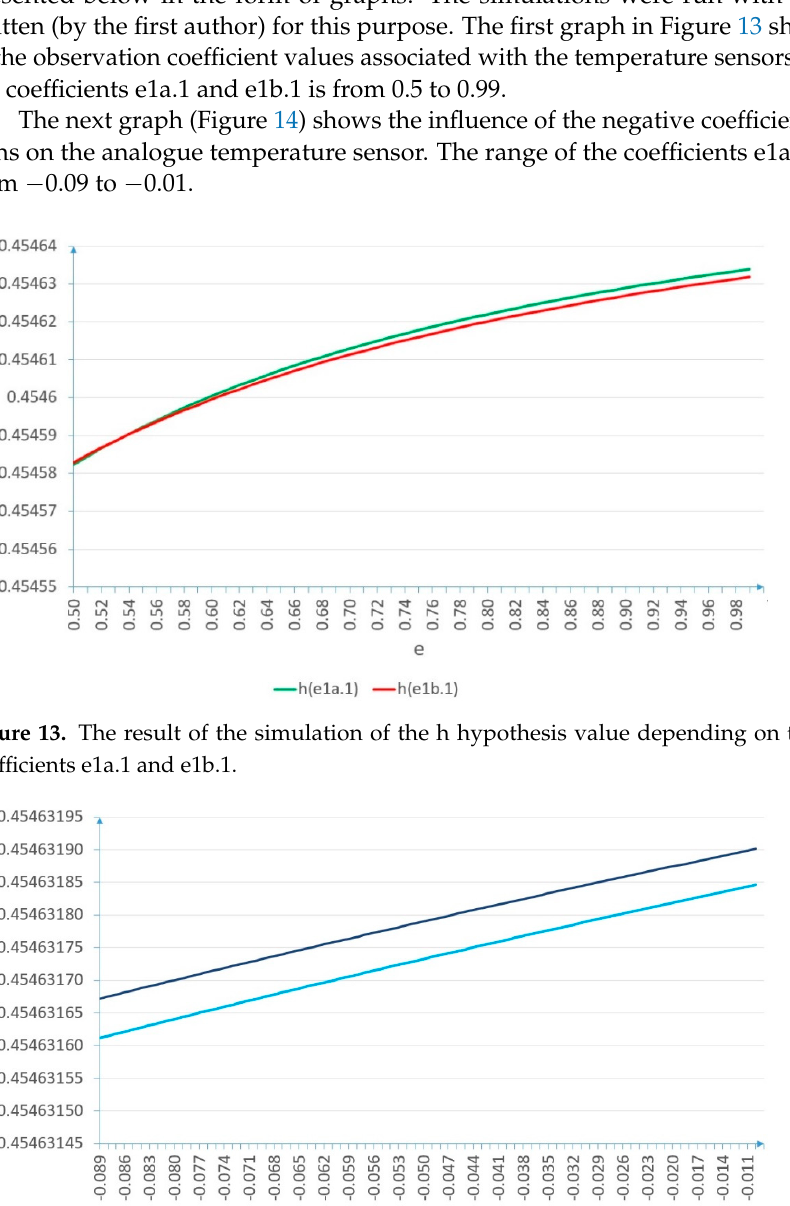
Figure 14. The result of the simulation of the h hypothesis value depending on the observation coefficients e1a.2 and e1a.3.